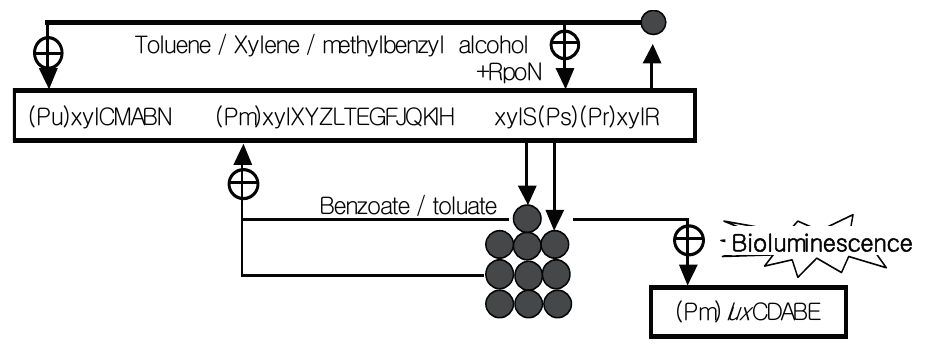
Figure 1. Regulation of TOL catabolic and recombinant Pm - lux genes ( ⊕ : positive control; ● : regulatory protein) (adapted from